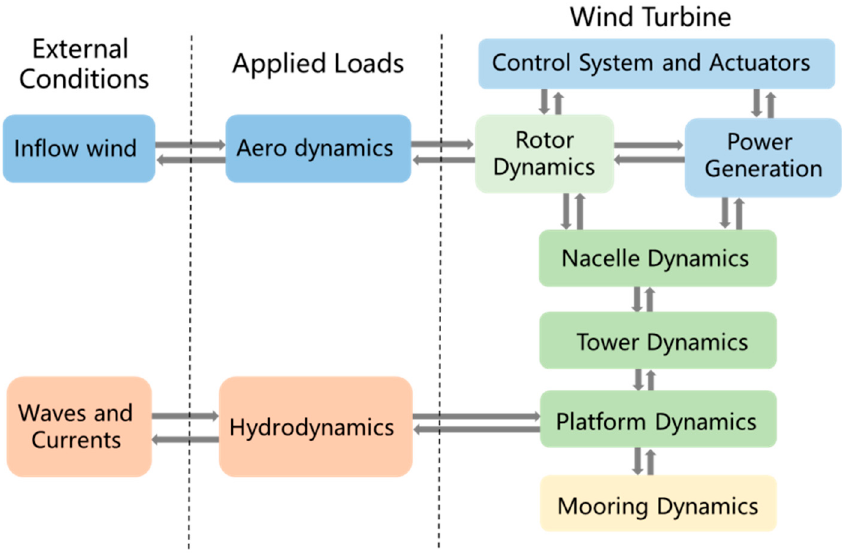
Figure 1. Sketch of the models in AFWT.